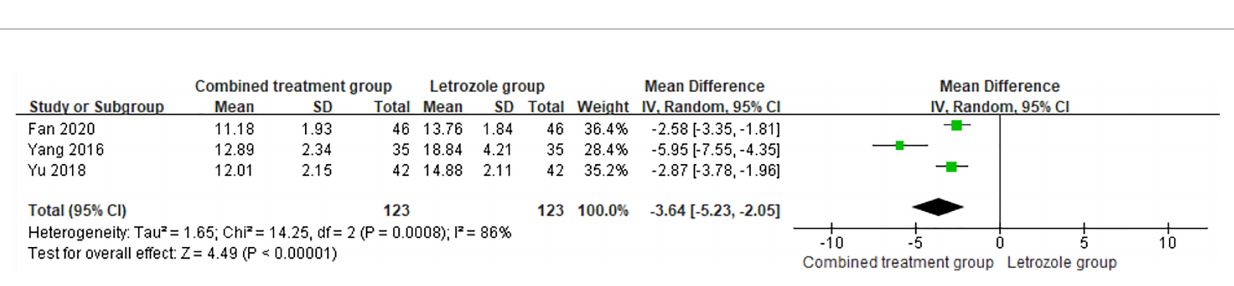
FIGURE 7 | Meta-analysis of the effect of Kuntai capsule combined with letrozole on prolactin (PRL) in the treatment of polycystic ovary syndrome (PCOS).